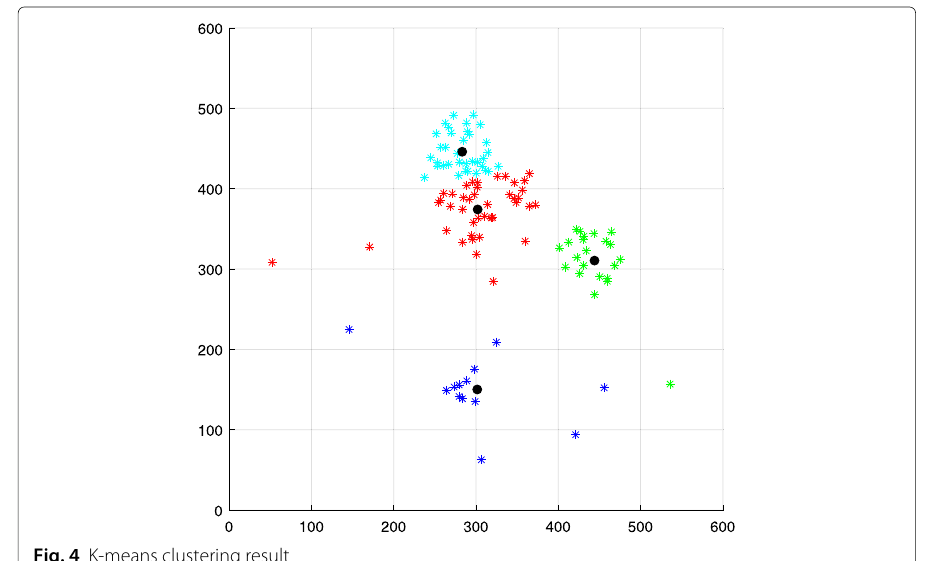
Fig. 4 K-means clustering result